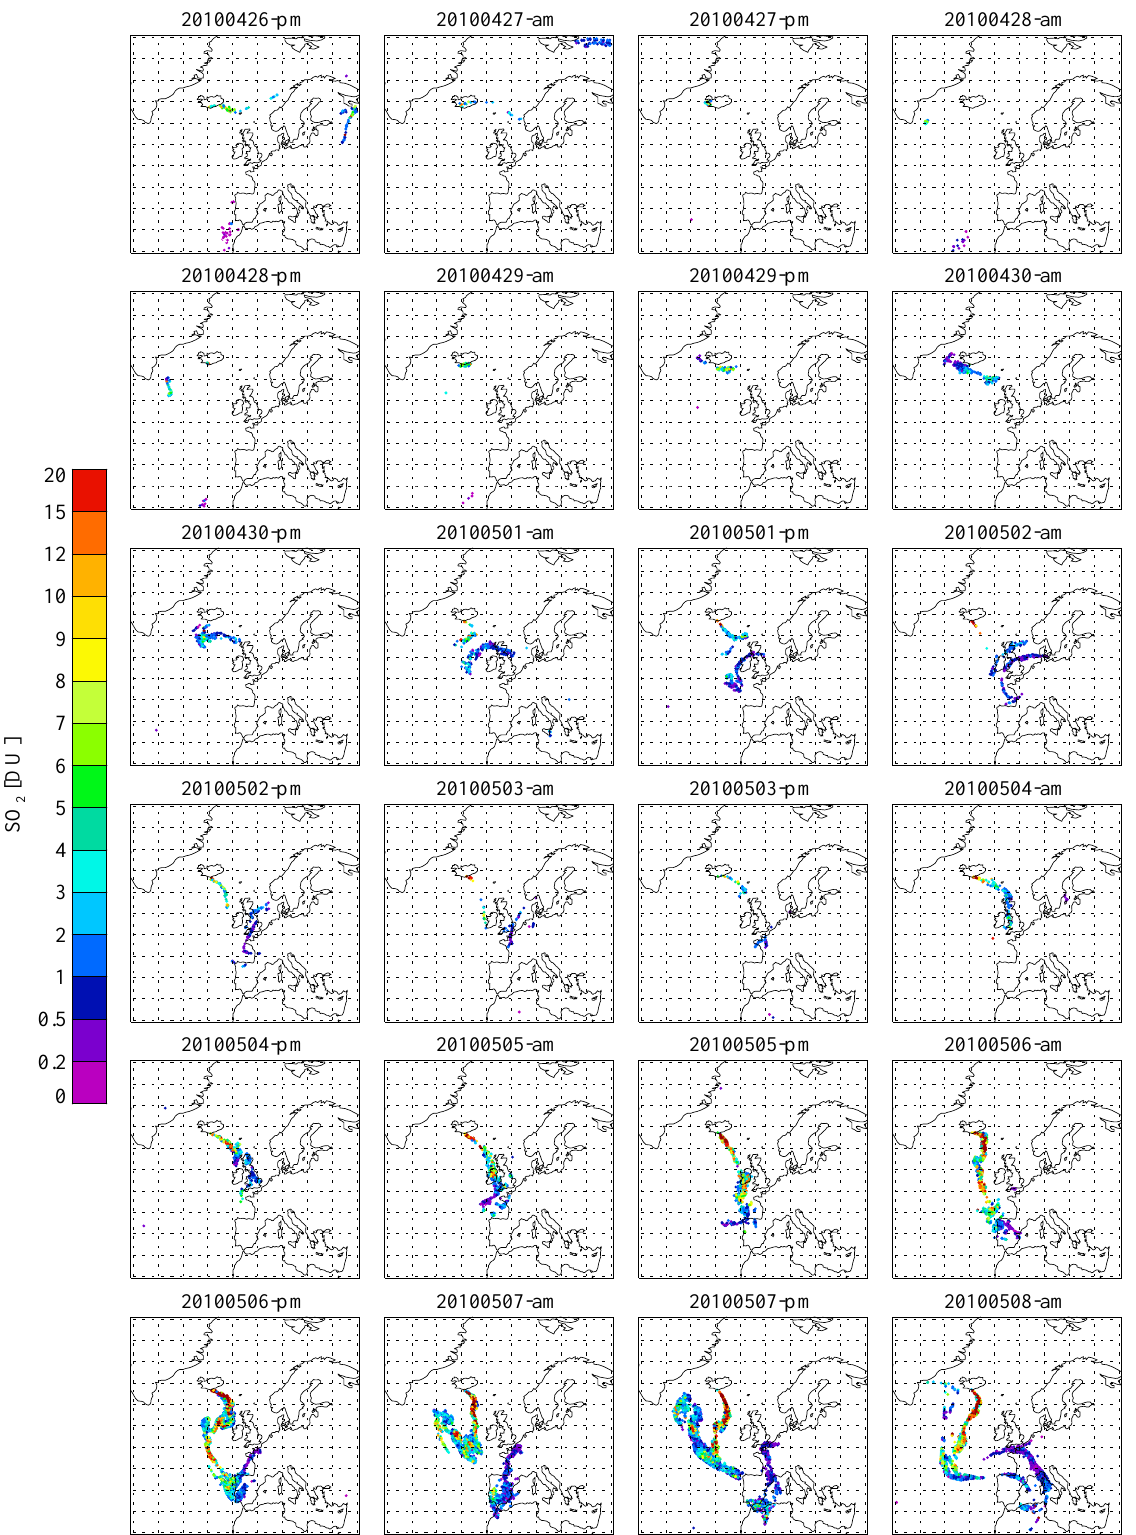
Fig. 8. IASI SO 2 column amount, divided into morning and afternoon orbits, for the period from 26 April 2010 to 8 May 2010.